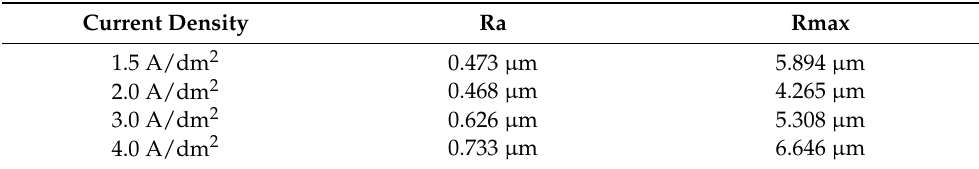
Figure 7. SEM characterization of surface morphology with different current density, ( A ) is 1.5 A/dm 2 , ( B ) is 2.0 A/dm 2 , ( C ) is 3.0 A/dm 2 and ( D ) is 4.0 A/dm 2 . Table 5. Ra and Rmax values with different current densities.